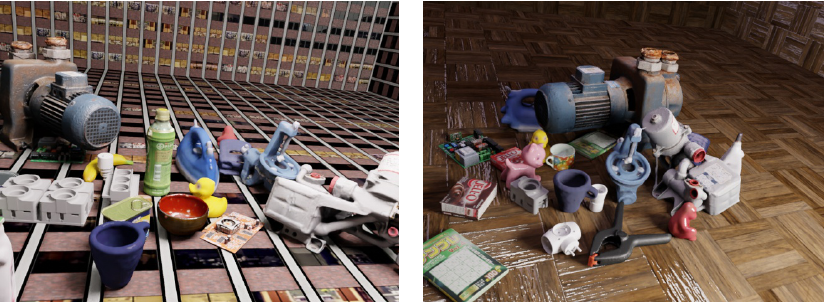
Figure 5. Photorealistic synthetic images generated using BlenderProc4BOP [18] with some of the 3D models used in our experiments, where other 3D models of different data sets, such as LINEMOD [15] or T-LESS [36], were used as distractors.